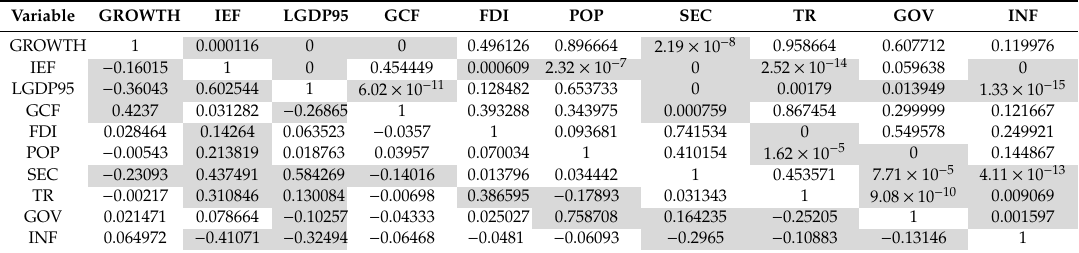
Table 3. Correlation matrix between dependent, independent variable and control variables.